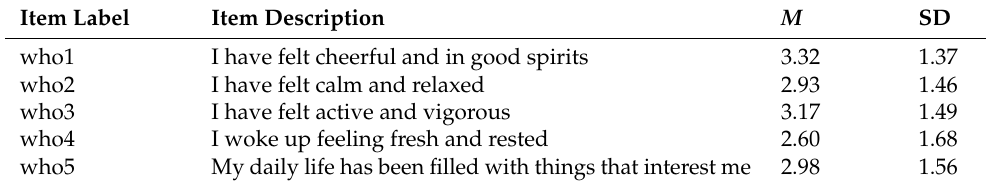
Table 2. Description of items ( N =